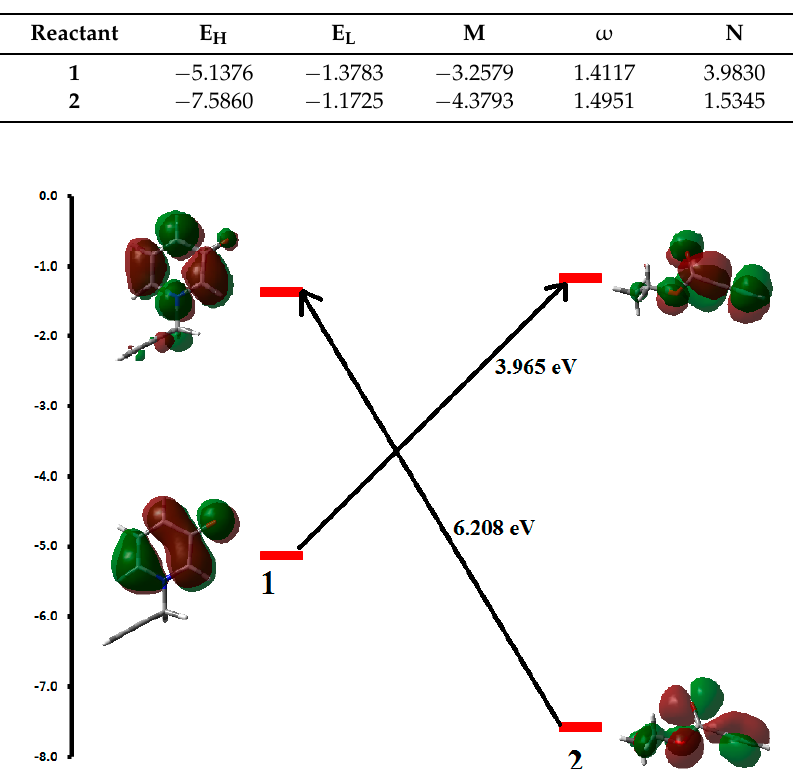
Figure 1 . Schematic representation of the possible interactions between the FMOs. Figure 1. Schematic representation of the possible interactions between the